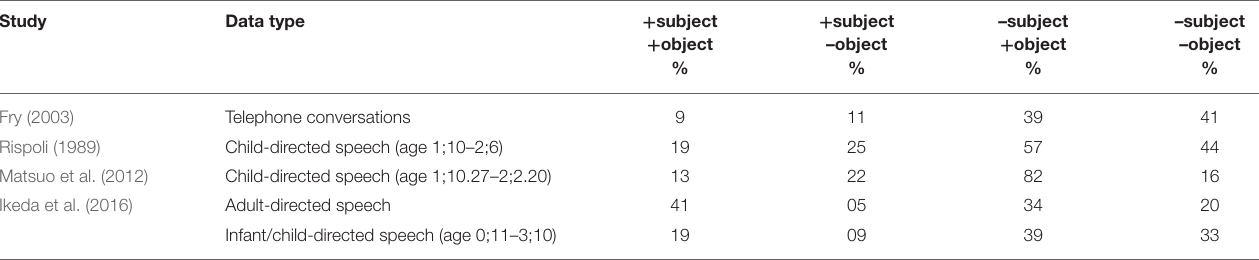
TABLE 2 | Previous findings of subject and object omission rates in Japanese ( + subject/object indicates an overt subject/object and –subject/object indicates a null subject/object). Study